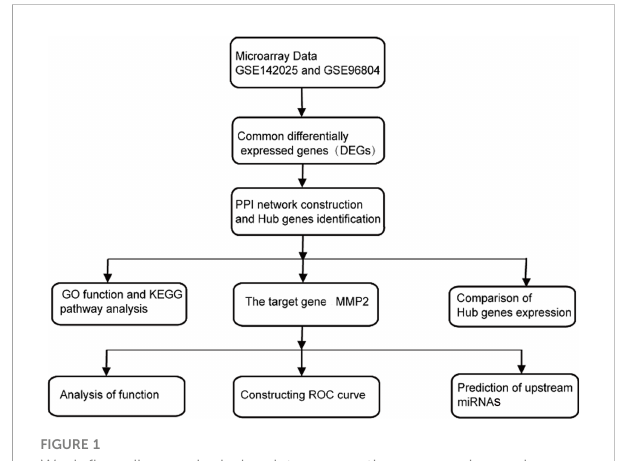
FIGURE 1 Work fl ow diagram includes data preparation, processing and